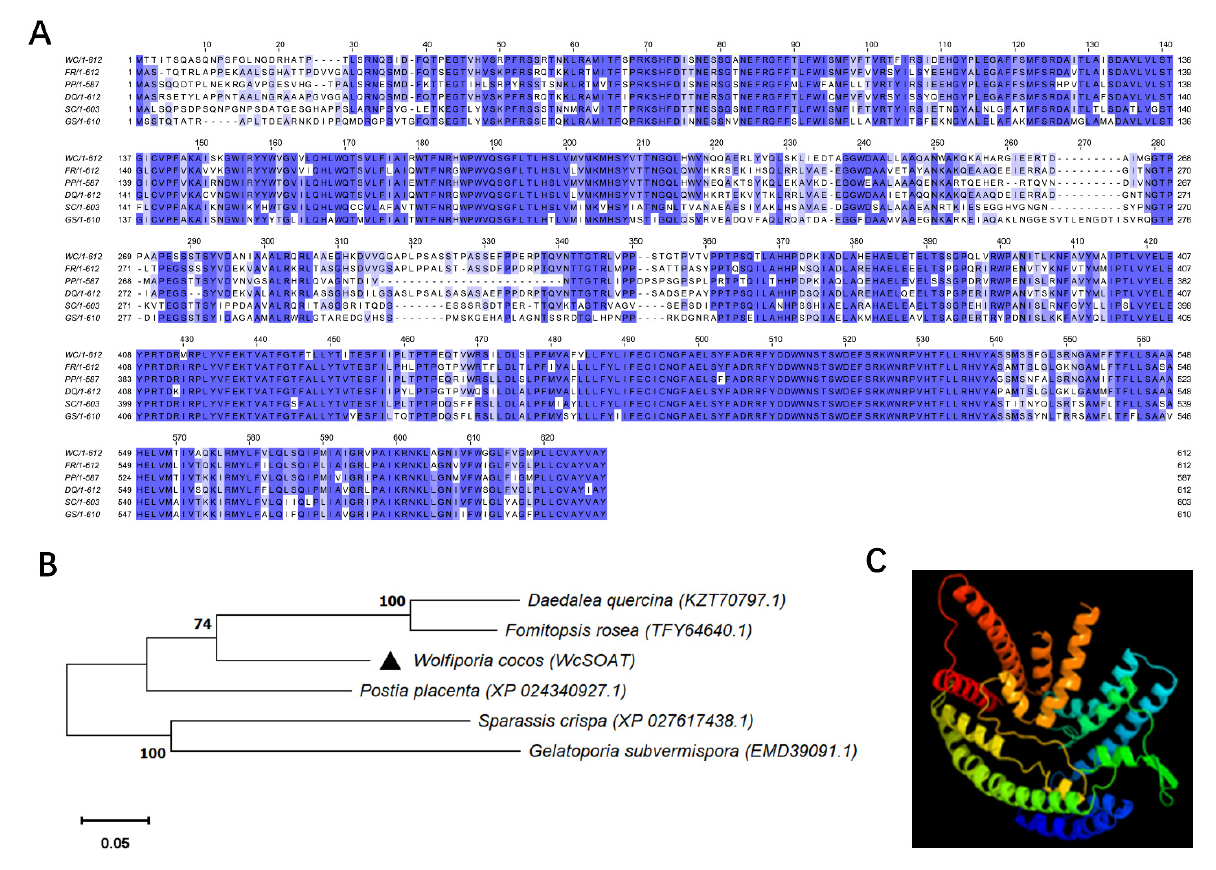
Figure 2. Sequence similarities between WcSOAT and its homologs. ( A ) Multiple sequence align- ment of WcSOAT and its homologs. Full-length protein sequences were aligned using Clustal W and the alignment was edited using Jalview. Intensity of blue shading reflects the level of amino acid identity at each position. WC: W. cocos ; FR: Fomitopsis rosea (TFY64640.1, 77.51%); PP: Postia placenta (XP_024340927.1, 75.25%); DQ: Daedalea quercina (KZT70797.1, 76.25%); SC: Sparassis crispa (XP_027617438.1, 65.95%); GS: Gelatoporia subvermispora (EMD39091.1, 63.92%). ( B ) Phylogenetic analysis of WcSOAT and its homologs from other species. The full-length protein sequences were analyzed using MEGA X with Unrooted neighbor-joining bootstrap (1000 replicates). The black triangle marks the location of WcSOAT. A scale bar at the lower left corresponds to a genetic distance of 0.05. ( C ) 3D structural models of WcSOAT, predicted using I-TASSER and further analyzed by PyMOL software.